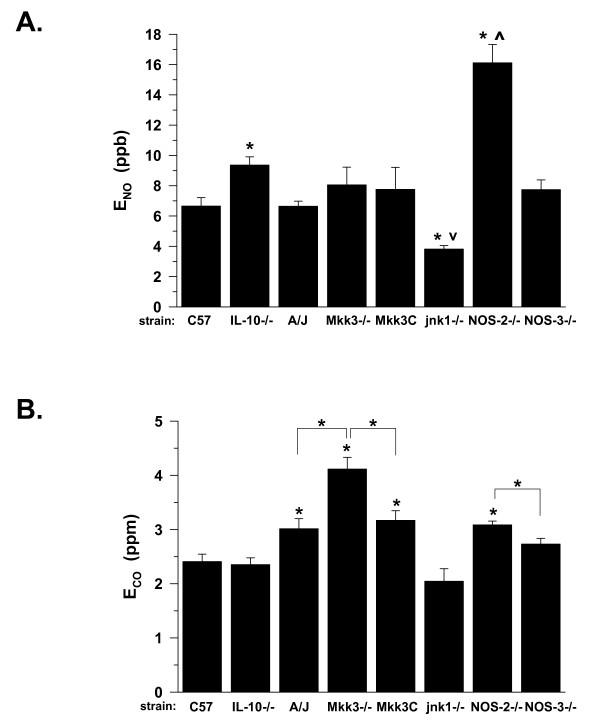
A. Exhaled NO (ENO) in naïve mice of various strains at 8–22 weeks of age. Values are means ± SE; *P < 0.05 vs. C57Bl6; vP < 0.05 JNK1-/- vs. MKK3-/-; ^P <0.05 NOS-2-/- vs. NOS-3-/-; strain(n) = C57Bl6(19), IL-10-/-(32), A/J(32), MKK3-/-(17), MKK3C (C57/C129(10)), JNK1-/-(11), NOS-2-/-(14), NOS-3-/-(19) B. Exhaled CO (ECO) in naïve mice. Values are means ± SE, with strain(n), and significance as in panel A; other significant differences as shown by *P<0.05 with brackets.